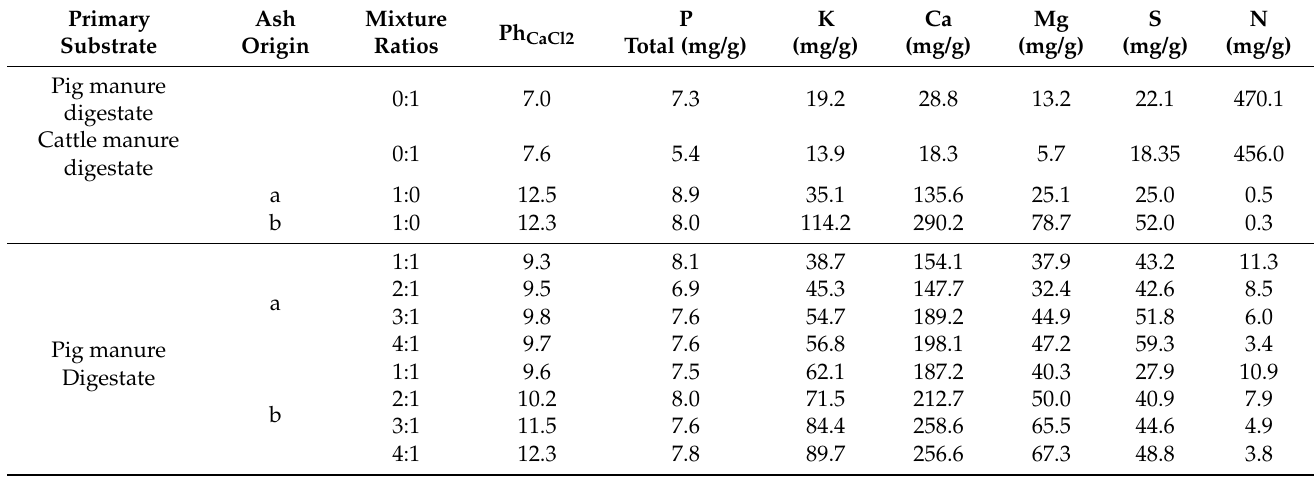
Table A1. Biogas digestate and wood ash mixture chemical composition, 29 April